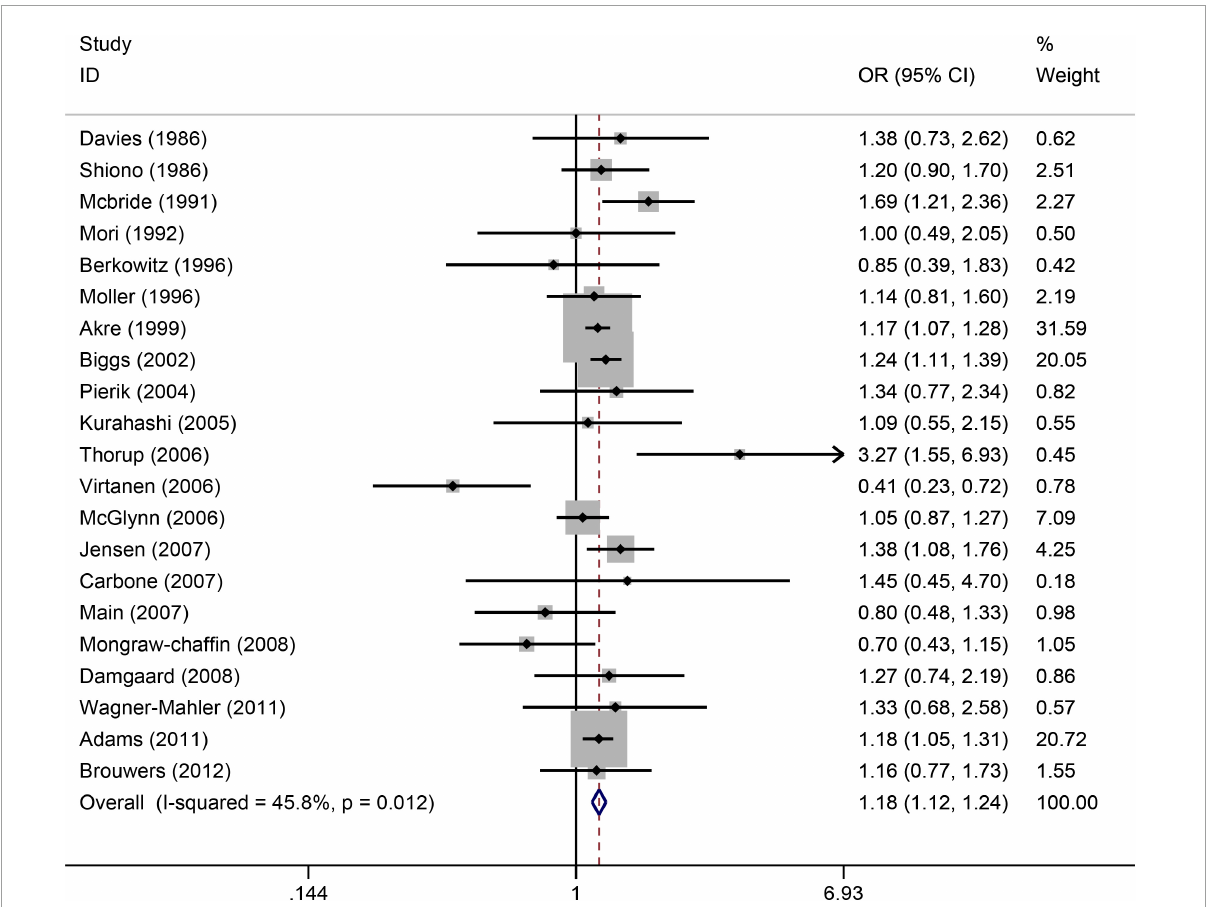
FIGURE3 Forest plot for between maternal smoking during pregnancy and the risk of cryptorchidism. Studies are sorted by the sequence of publication time.